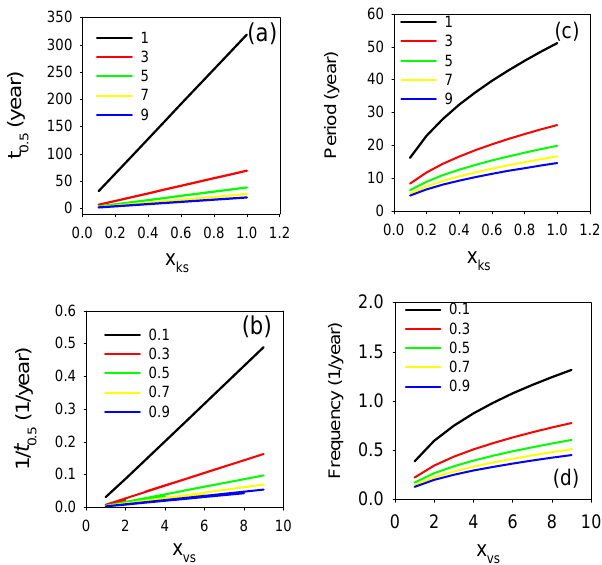
Fig. 4. Variation in the two-pool soil model at a soil temperature of Figure 4. Variation in the two-pool soil model at a soil temperature of 15 o C of (a) half-time ( t 0.5 ) with 787 15 ◦ C of (a) half-time ( t 0 . 5 ) with x ks at different values of x vs (1, 3, x ks at different values of x vs (1, 3, 5, 7, 9), (b) 1/ t 0.5 with x vs at different x ks (0.1, 0.3, 0.5, 0.7, 0.9); (c) 788 5, 7, 9), (b) 1 /t 0 . 5 with x vs at different x ks (0.1, 0.3, 0.5, 0.7, 0.9); (c) period of oscillation ( p ) with x ks at different values of x vs (1, 3, period of oscillation ( p ) with x ks at different values of x vs (1, 3, 5, 7, 9) and (d) frequency of oscillation 789 5, 7, 9) and (d) frequency of oscillation (1 /p ) with x vs at different (1/ p ) with x vs at different x ks (1, 3, 5, 7, 9). 790 x ks (1, 3, 5, 7, 791